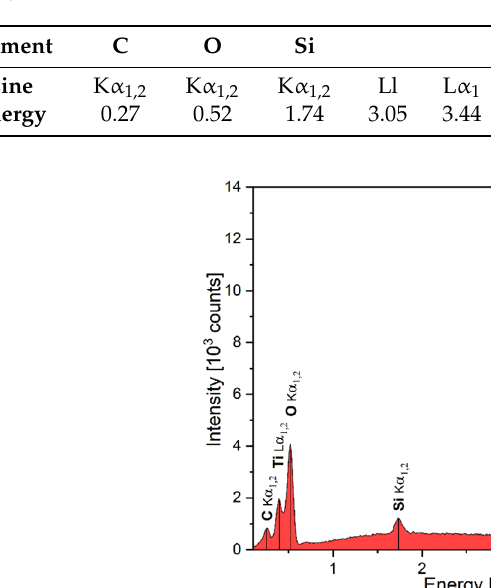
Figure 2. Height histograms received from the TiO 2 step, imaged by an optical profilometer. Bare FTO surface is represent by the cyan color and the thin film of TiO 2 is indicated by the olive color. The difference between the Gauss peak centers determines the layer thickness.